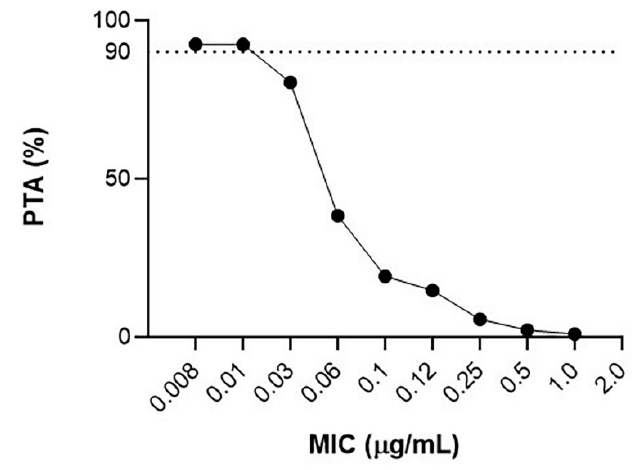
Figure 3. Probability of target attainment ( ≥ 90%) using a Monte Carlo simulation with 1000 hypo- thetical trials, when doxycycline at 5 mg/kg is administered via subcutaneous injection (diluted at 50:50 with saline), at serial doubling doxycycline MICs for AUC/MIC target ≥ 24.